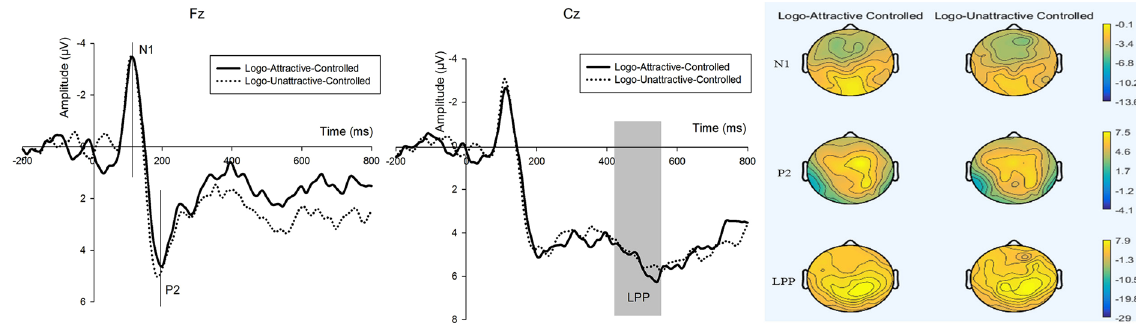
Figure 3. Wavefroms and brain topographic maps of N1, P2 and LPP of logo onset in experiment 2. Fz and Cz were chosen to represent.